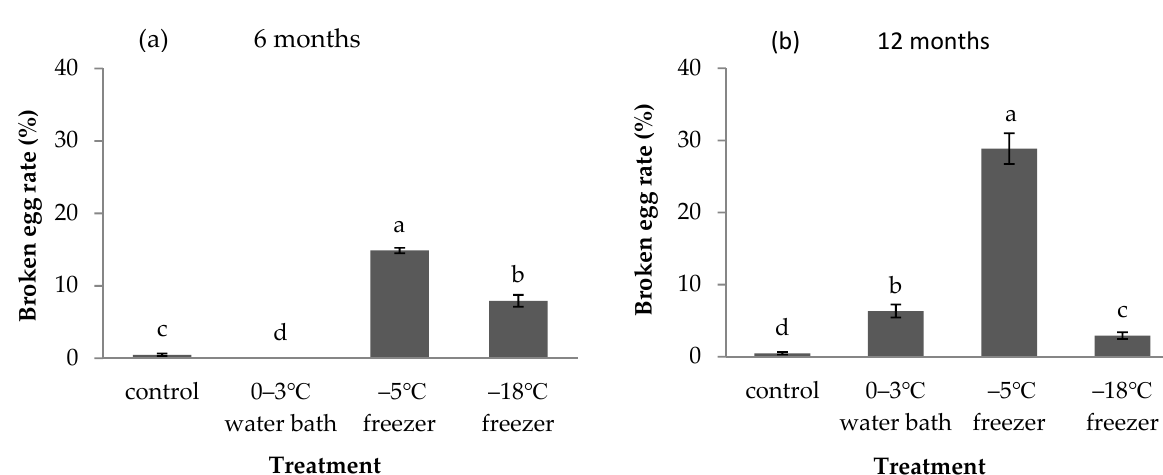
Figure 1. Rate of broken A. pernyi eggs that were stored at a low temperature for 6 months ( a ) and 12 months ( b ) (mean ± SE%). Control represents fresh eggs. Bars sharing the same letters are not significantly different (one-way ANOVA, fol- lowed by LSD multiple comparison tests, p < 0.05) between different treatments.